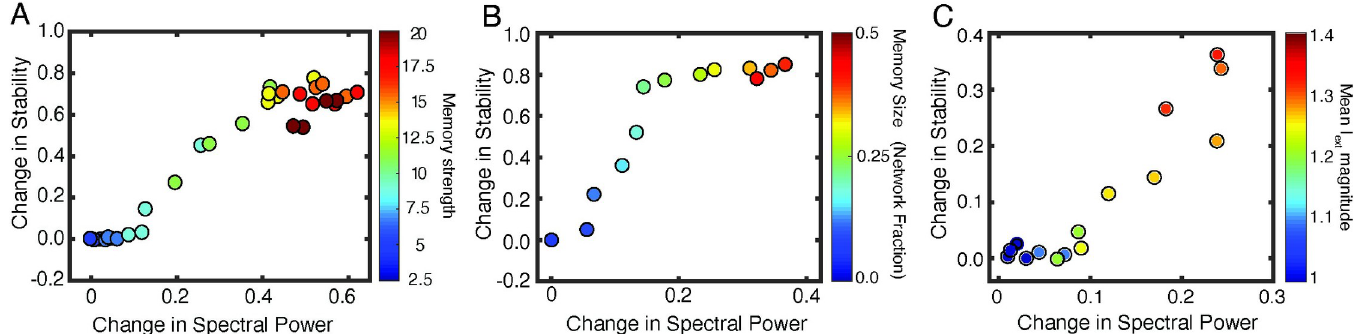
Fig 2. Memory-driven changes in network stability. Change in functional network stability (FuNS) and spectral theta power in response to strengthening of subset of reciprocal excitatory-to-excitatory connections (A) (color scale corresponds to synaptic multiplier), (B) different number of cells undergoing initial synaptic strengthening (color scale corresponds to fraction of cells that had strengthened incoming synapses), C) change in mean external current, I ext , received by excitatory neurons in absence or reciprocal excitatory-to-excitatory connections. In A the fraction of network with synapses strengthened was 25%; in B the strengthening multiplier was set to 20.